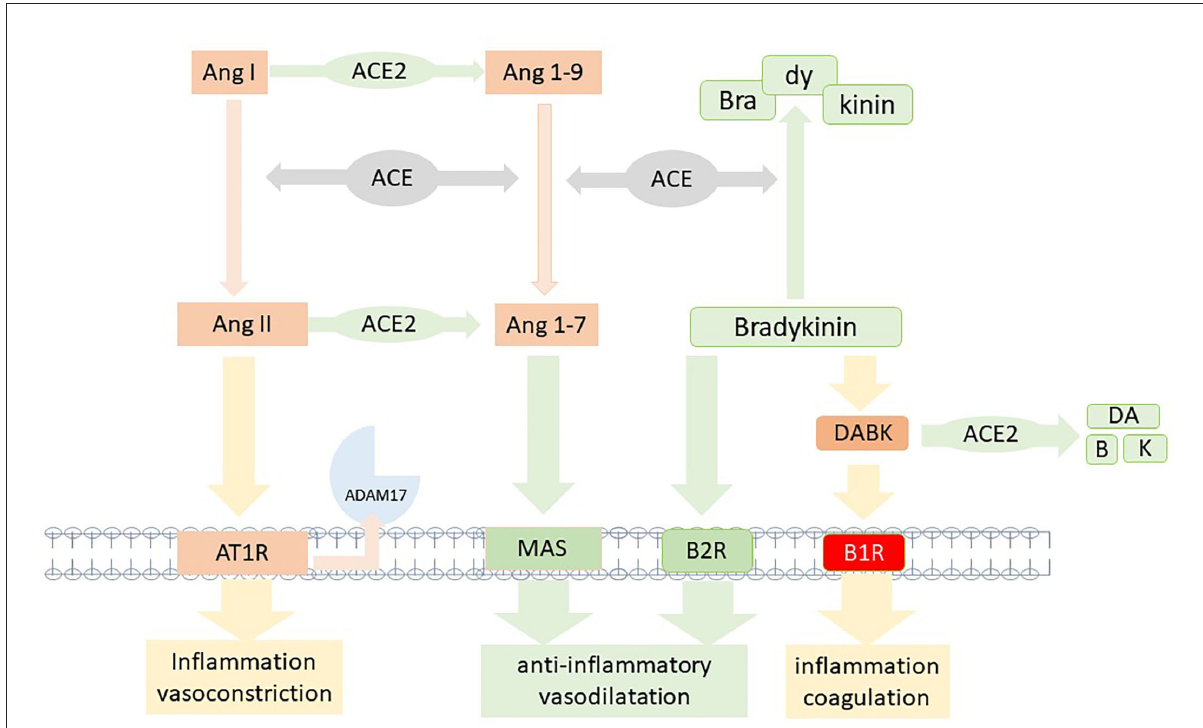
FIGURE2 Model of the two competing axis of the renin-angiotensin system. In brief, AngiotensinII/Angiotensin II type 1 receptor (AngII/AT1R) and the Ang (1-7)/MAS receptor; the counterbalancing bradykinin system with degradation due to angiotensin-converting enzyme (ACE) and [des-Arg9]-bradykinin (DABK) by angiotensin-converting enzyme 2 (ACE2). Inactivation of ACE2 due to infection or vaccine would impair the anti-inflammatory Ang (1-7)/MAS and DABK degrading pathways, resulting in RAS imbalance and bradykinin-1 receptor (B1R)